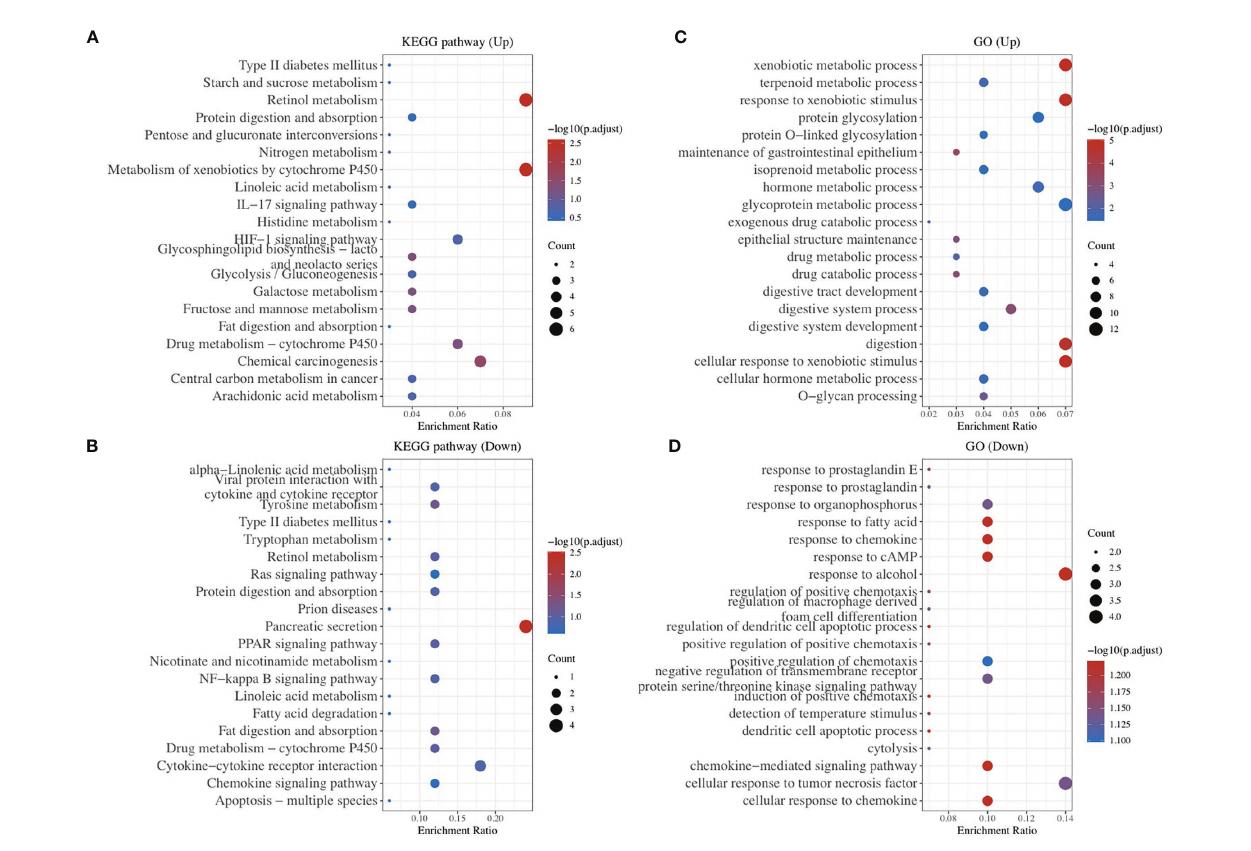
FIGURE 7 | Enrichment Analysis of DEGs identi fi ed from comparing CA9 high expression group and low expression group. (A, B) Bubble plot of signi fi cant KEGG pathways. X-axis indicates the gene ratio, whereas the Y-axis shows the most enriched KEGG pathways. And the size of bubble presents genes number, and the color of bubble presents the P value. (C, D) GO analyses of the DEGs according to their biological process, cellular component and molecular function. X-axis indicates the gene number, whereas the Y-axis shows the most enriched GO